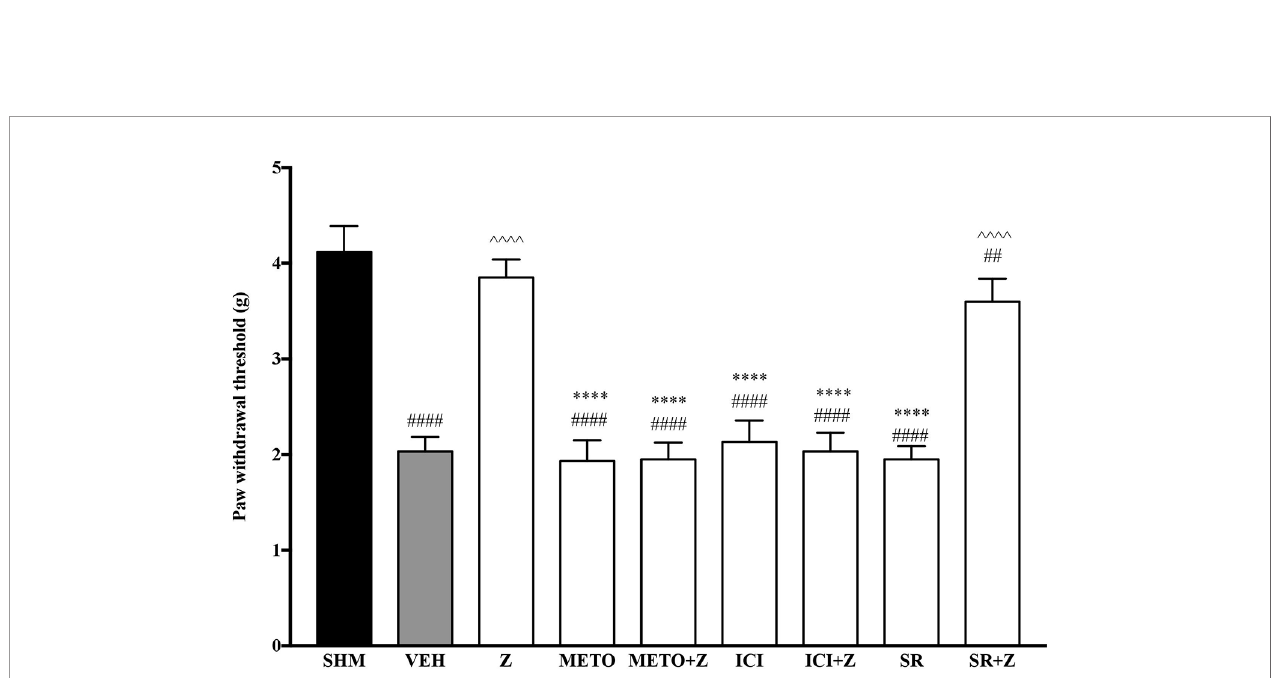
FIGURE 5 | Effect of metoprolol ( b 1 -adrenoceptor antagonist), ICI 118, 551 ( b 2 -adrenoceptor antagonist) and SR 59230 A ( b 3 -adrenoceptor antagonist) pre- treatment on zerumbone against mechanical allodynia in CCI-induced neuropathic pain mice. Data are presented as mean ± SEM (n = 6). ## p < 0.01, #### p < 0.0001 as compared to sham, ^^^^ p < 0.0001 as compared to vehicle and **** p < 0.0001 as compared to zerumbone-treated group. SHM (Sham); VEH (Vehicle, 10 mL/kg i.p.); Z (Zerumbone, 10 mg/kg i.p.); METO (Metoprolol, 1 mg/kg i.p.); ICI (ICI 118,551, 2 mg/kg i.p.); SR (SR 59230 A, 2.5 mg/kg i.p.).